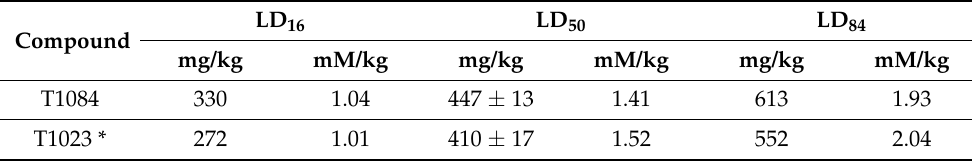
Table 1. T1084 and T1023 acute toxicity for male outbred mice, single i.p. administration.